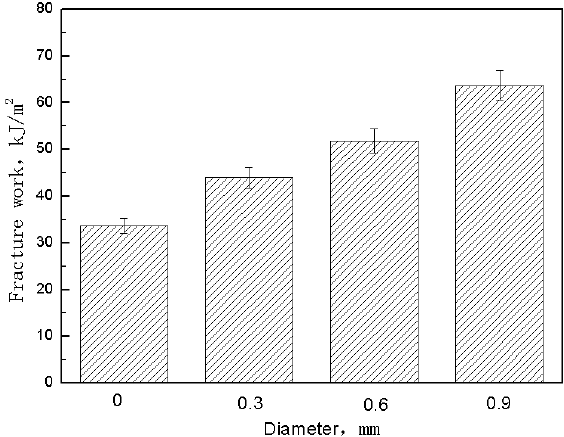
Figure 9. Effect of metal pin diameter on fracture work of z-pinned Cf/Al composites using stainless steel pins with a volume content of 1%.